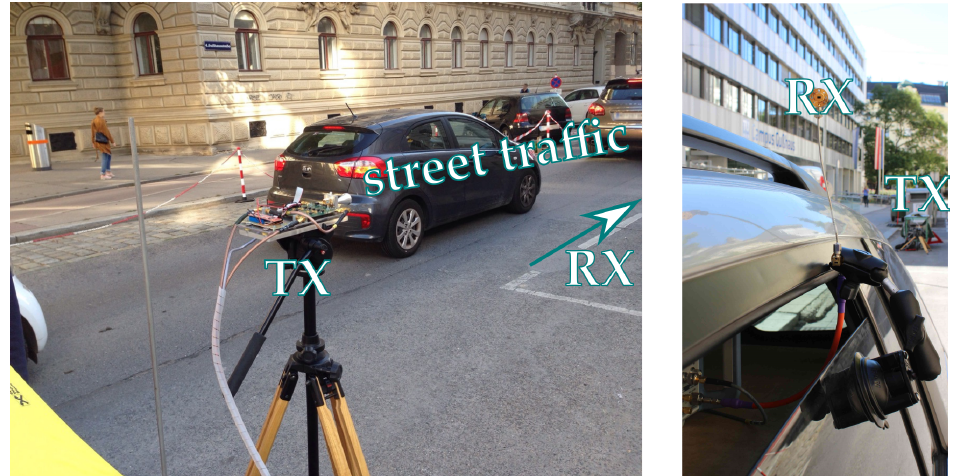
Figure 5. Zoomed photographs of the measurement site. On the left-hand side, the photo shows the transmit horn antenna mounted on a tripod. As multiple reflection with the transmitter car are below our receiver sensitivity, the TX car is replaced with a tripod. On the right-hand side, the photo shows the open-ended waveguide receive antenna mounted at roof height at the left, rear car side